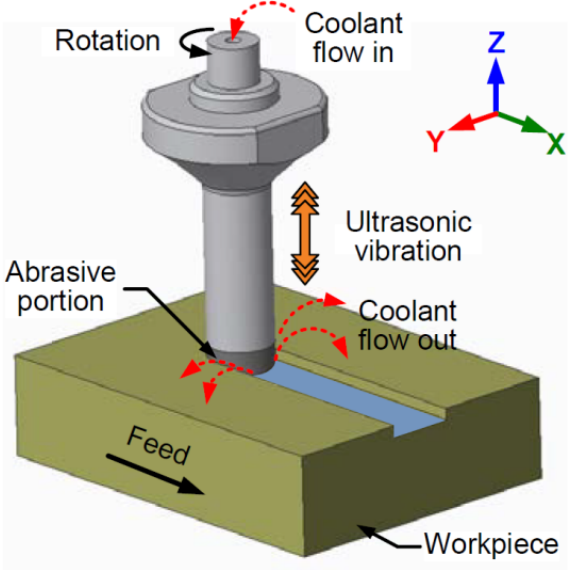
Figure 12. Scheme of RUSM process (Reprinted with permission from Ref. [135]. 2017, copyright Elsevier B.V.).